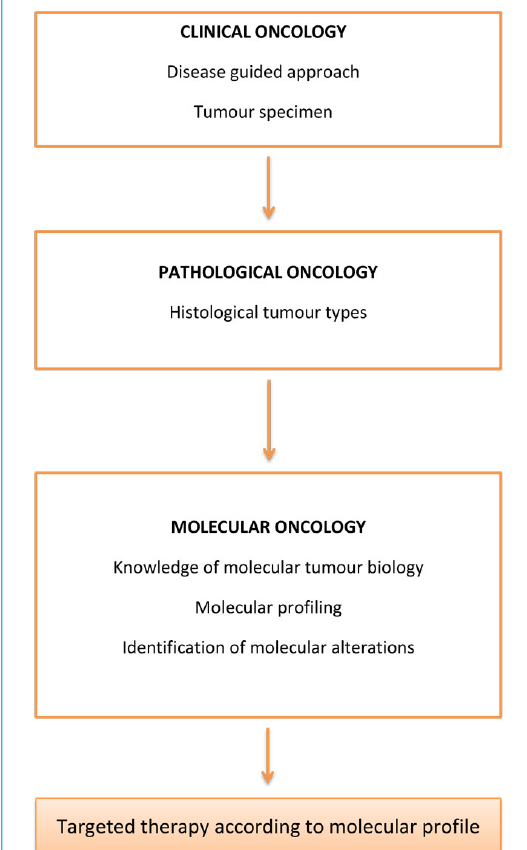
Figure 1: Conceptual evolution of oncological clinical